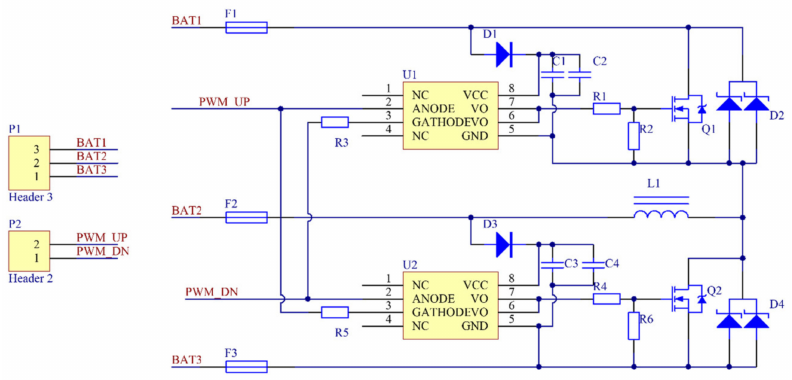
Figure 6. Hardware schematic of the balanced